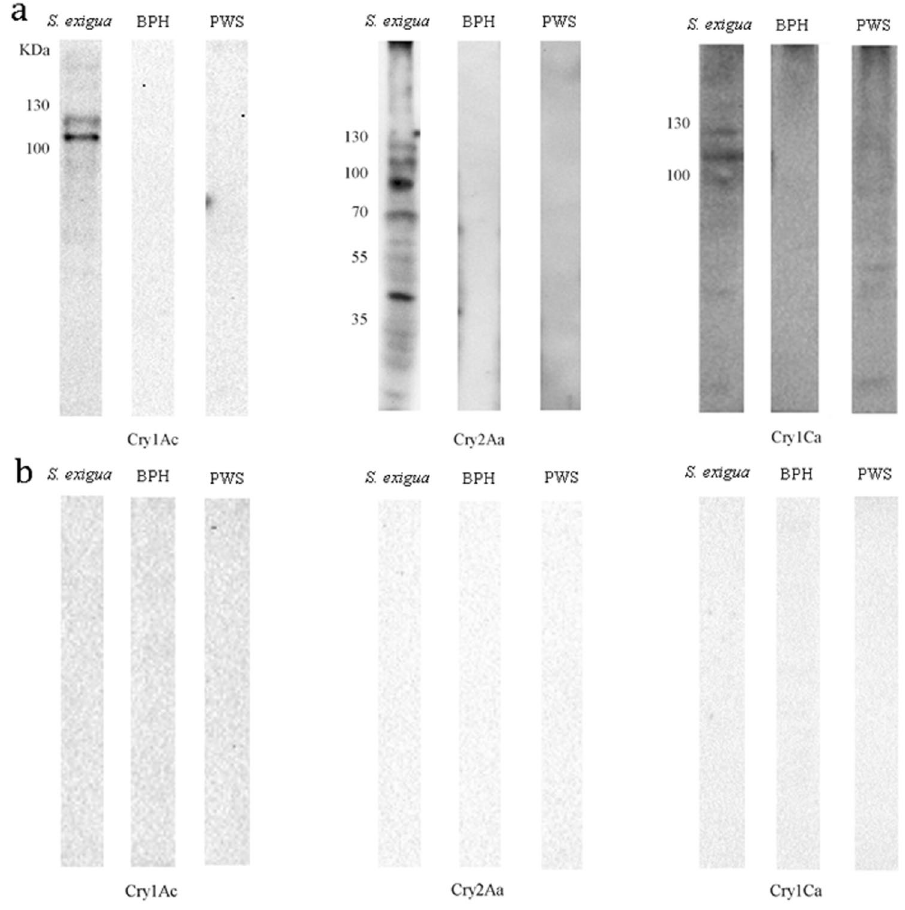
Figure 2. Ligand blots of Cry1Ac, Cry2Aa and Cry1Ca toxins with BPH and PWS BBMV proteins. ( a ) PVDF membranes from BPH and PWS BBMV were incubated with activated Cry toxin, primary antibody, and secondary antibody. ( b ) PVDF membranes from BPH and PWS BBMV were incubated with primary antibody and secondary antibody. S . exigua gut BBMV proteins were used as a positive control